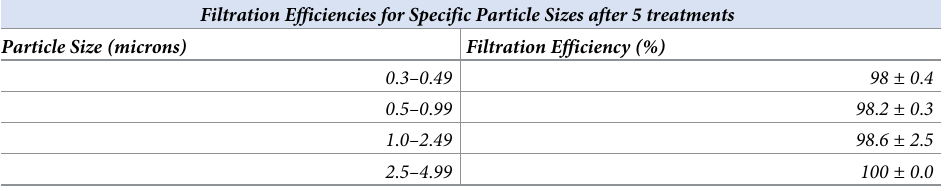
Table 1. Filtering efficiency of particles for different particle sizes after the 5th treatment cycle.